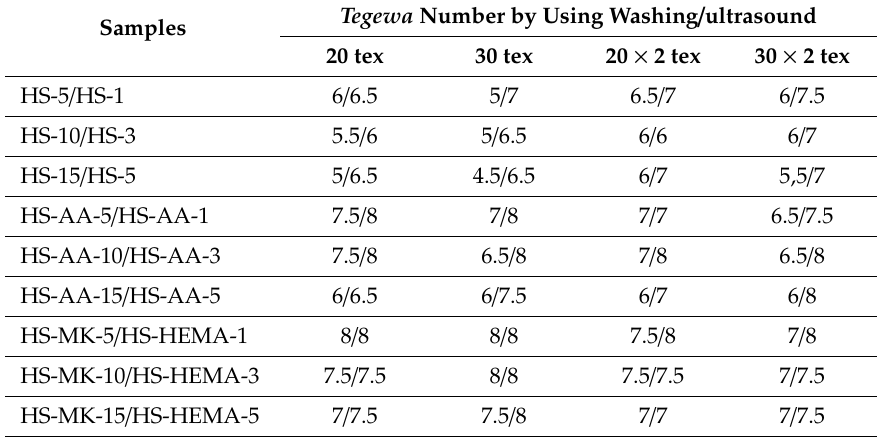
Table 9. Tegewa classification of desizing performance (by classic washing / ultrasound).